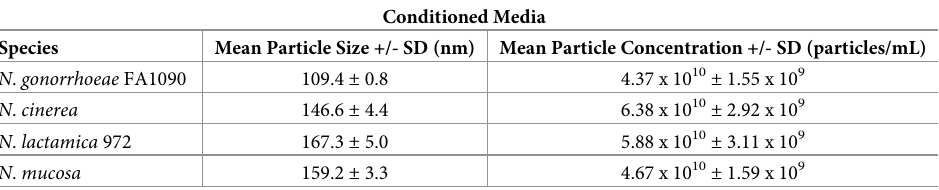
Table 2. Mean particle sizes and concentrations of OMVs in CM from the four Neisseria species.